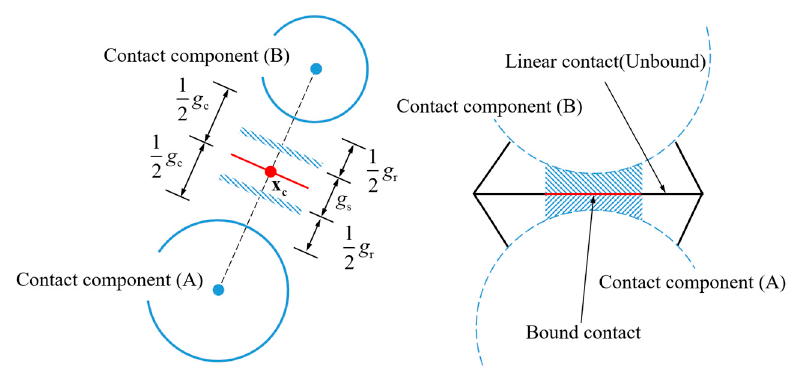
Figure 4. Sketch of the bound contact model.